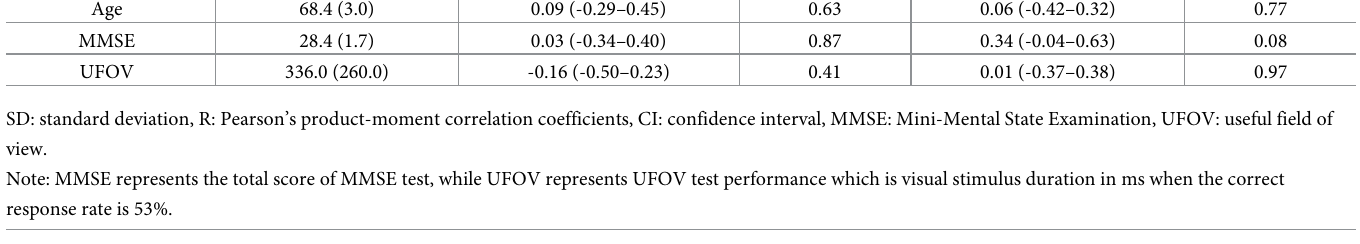
Note: MMSE represents the total score of MMSE test, while UFOV represents UFOV test performance which is visual stimulus duration in ms when the correct response rate is